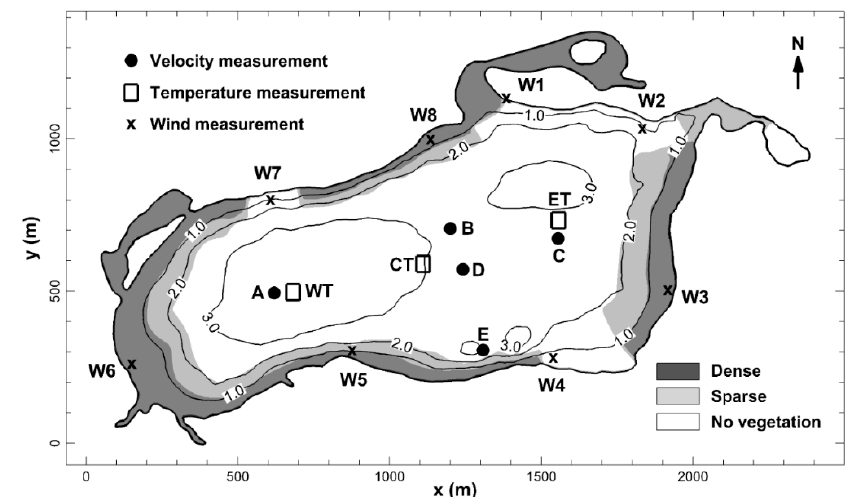
Figure 1. Lake Wingra bathymetry and the distribution of littoral-zone vegetation. Symbols ( ● , □ and × ) represent the locations of wind (W1-W8), water temperature (WT, CT, ET), and velocity profile measurements (A, B, C, D, and E), respectively.